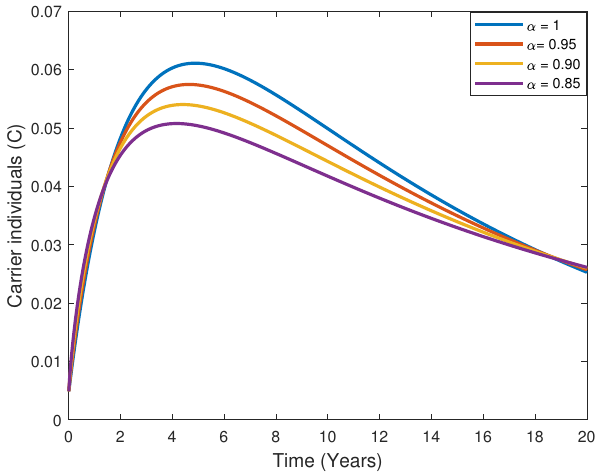
Figure 6. Behavior of C class for different α values.